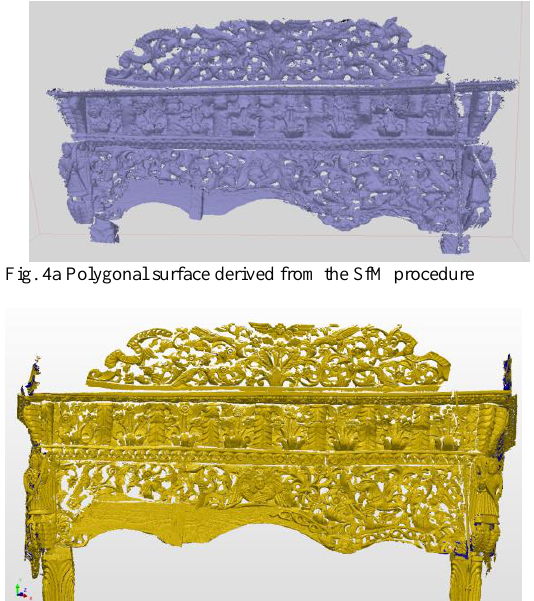
Fig. 4b Polygonal surface derived from the scanning